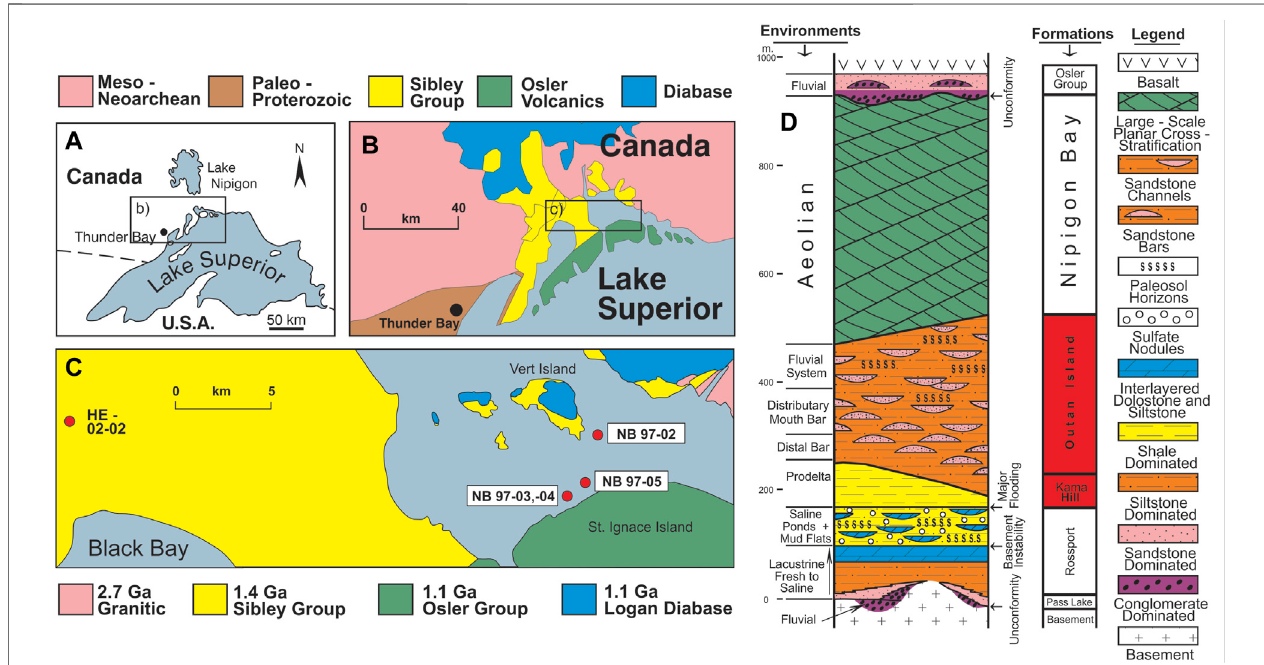
FIGURE1|(A) Locationmapofthestudyarea.Boxdelineatesregioncoveredin Figure1B . (B) OutcropareaoftheSibleyGroup.Boxdelineatesregioncoveredin Figure 1C . (C) Locations ofthefour cored drill-holesused in thisstudy. (D) Stratigraphy and depositionalenvironments representedby theSibley Group. The Kama Hill and Outan Island Formations studied here are in